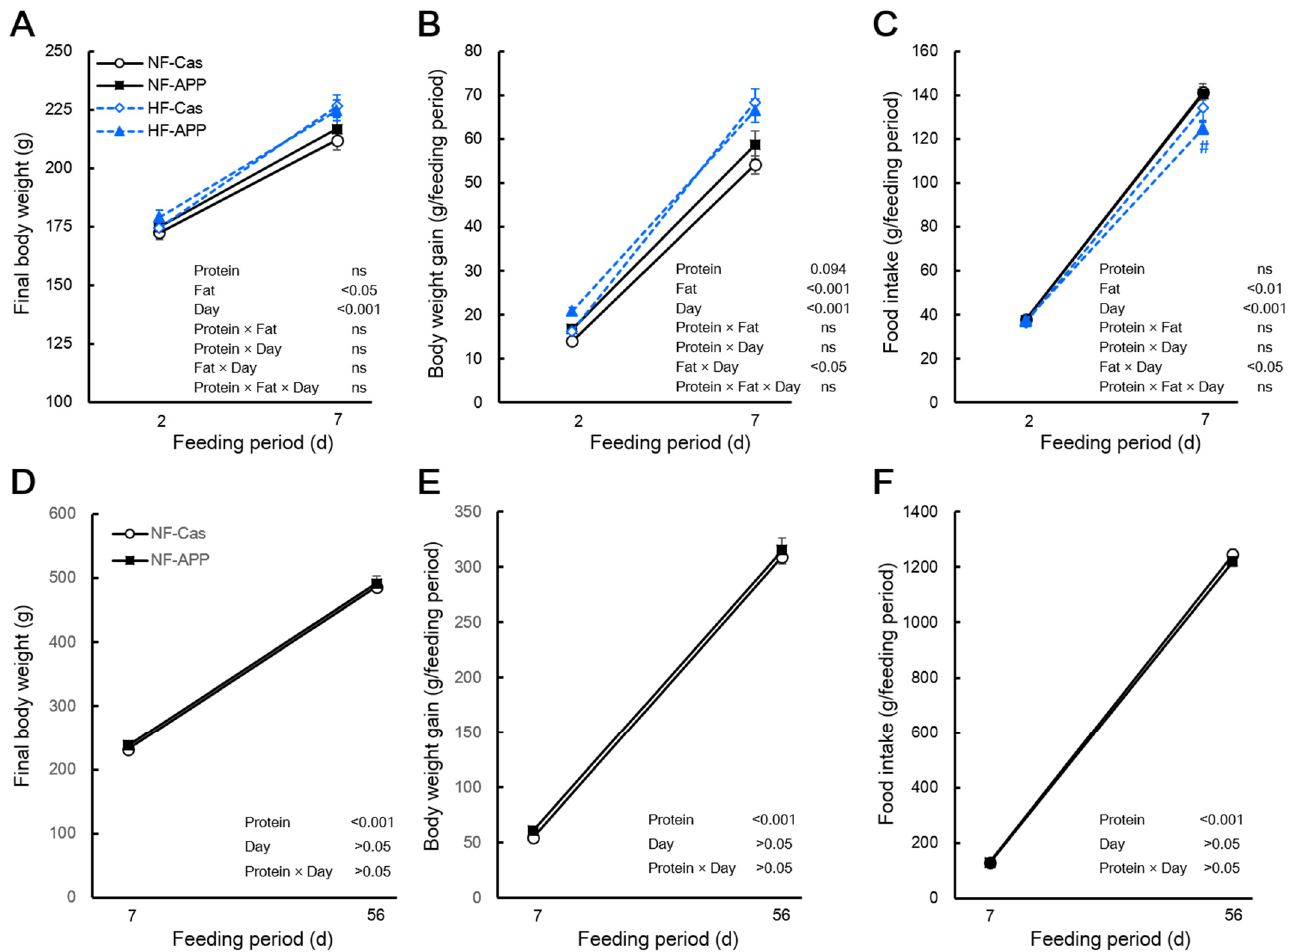
Figure 1. Effects of APP on the final body mass, body mass gain and food intake. The final body mass ( A ), body mass gain ( B ), and food intake ( C ) of normal-fat-casein (NF-Cas) group, normal-fat-APP (NF-APP) group, high-fat-Cas (HF-Cas) group, and high-fat-APP (HF-APP) group after 2 days of feeding ( n = 8/group) and 7 days feeding ( n = 9/group) in experiment 1, and the final body mass ( D ), body mass gain ( E ), and food intake ( F ) NF-Cas group and NF-APP group after 7 days of feeding ( n = 10/group) and 56 days feeding ( n = 10/group) in experiment 2, are shown. Data are expressed as the mean ± standard error (SEM). Statistical analyses were performed using three-way ANOVA with Bonferroni post hoc significance testing in experiment 1, and two-way ANOVA with Bonferroni post hoc significance testing in experiment 2. Asterisks indicate significant differences compared to NF-Cas group, and number signs indicate significant differences compared to HF-Cas group ( # p < 0.05). Protein, effect of protein source; Fat, effect of fat content; Days, effect of feeding period; Protein × Fat, interaction between protein source and fat content; Prorein × Days, interaction between protein source and feeding period; Fat × Day, interaction between fat content and feeding period; Protein × Fat × Day, interaction between protein source, fat content and feeding period; ns, not